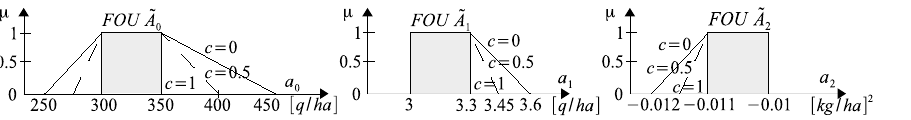
Figure 35. Footprints of uncertainty FOUs of T2FNs ˜ A 0 , ˜ A 1 , ˜ A 2 representing knowledge about fertilization